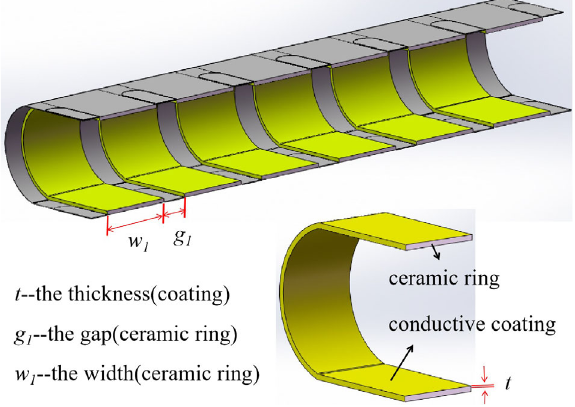
FIG. 10. Ceramic rings with a high conductivity coating.